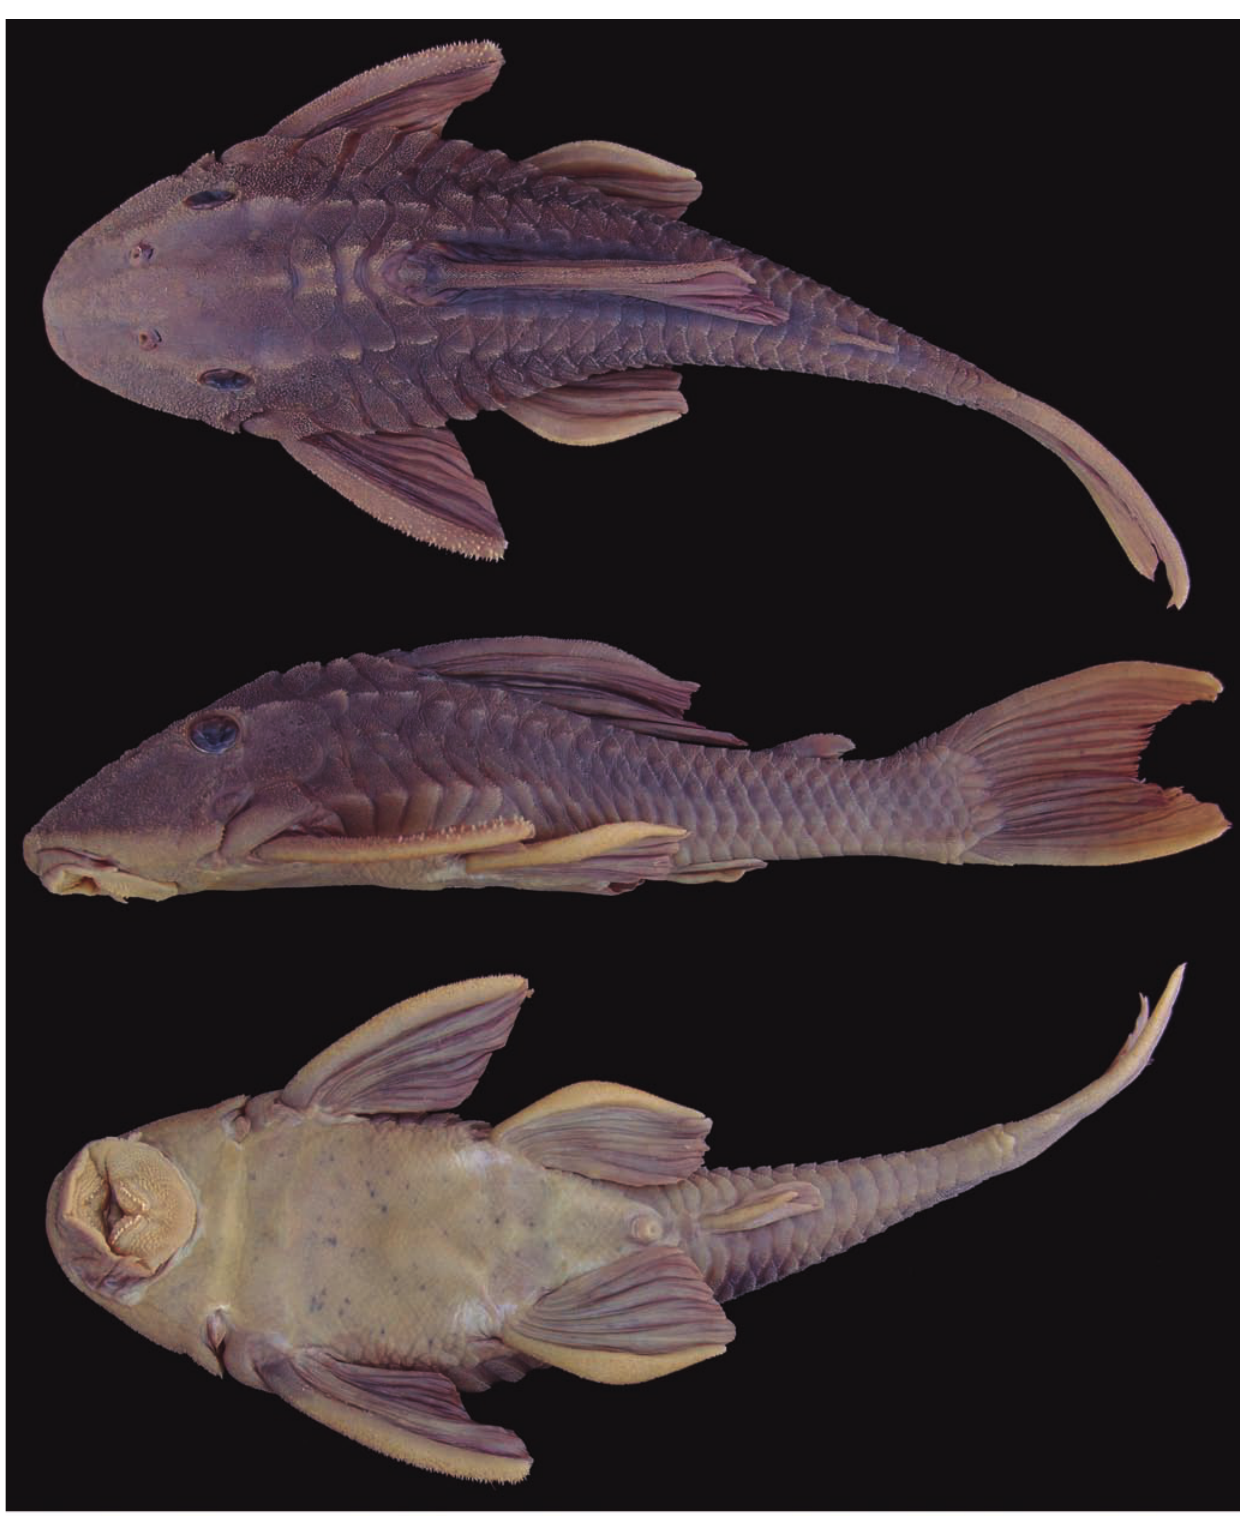
Fig. 10. Hypostomus basilisko , holotype, MZUSP 111110, 182.5 mm SL, córrego Salobrinha, rio Paraguay basin, Mato Grosso do Sul, Brazil; dorsal (top), lateral (middle), and ventral (bottom)